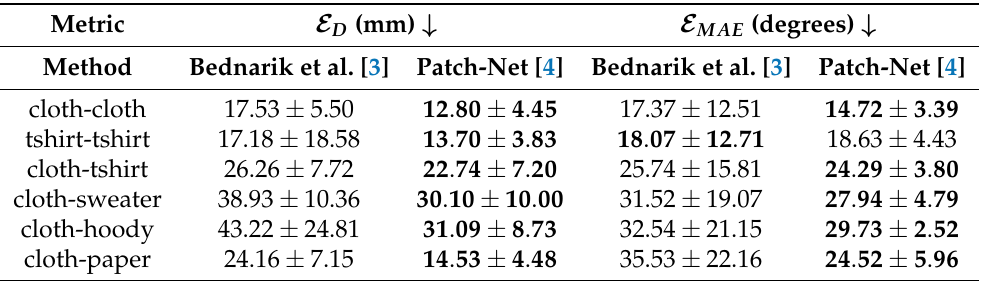
Table 4. The textureless surfaces dataset [3] is used to compare the performance of different depth and normal map reconstruction methods. 128 × 128 size patches were used in the Patch-Net. Bold values show the best results for each